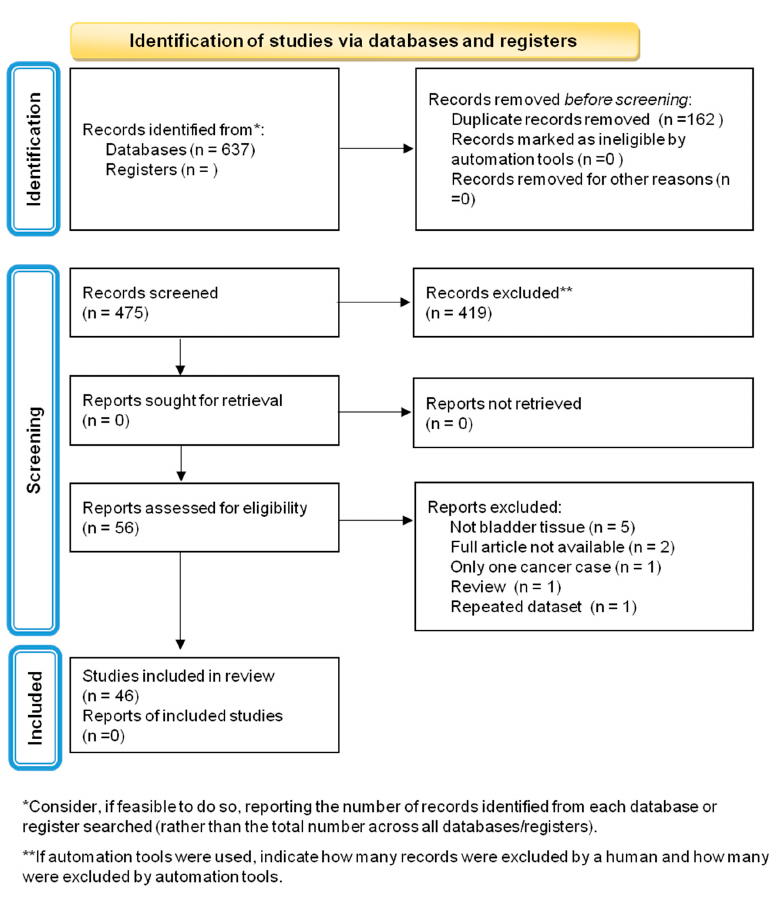
Figure 1. PRISMA 2020 flow diagram for new systematic reviews, which included searches of databases and registers only.